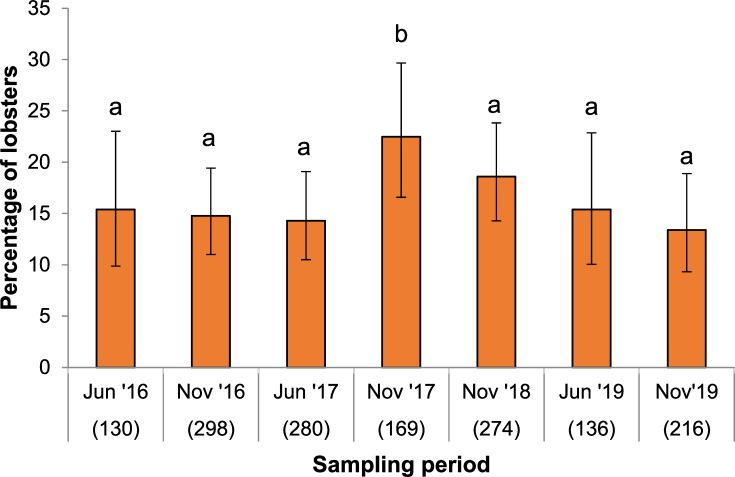
Clinical prevalence of PaV1 over time.Clinical prevalence of PaV1 (percentage of lobsters visibly infected, i.e., diseased) throughout the Puerto Morelos reef lagoon in seven sampling periods: June 2016 (Jun ‘16), November 2016 (Nov ‘16), June 2017 (Jun ‘17), November 2017 (Nov ‘17), November 2018 (Nov ‘18), June 2019 (Jun ‘19), and November 2019 (Nov’19). Numbers in parentheses are sample sizes. Error bars denote 95% confidence intervals. Different letters above bars denote significant differences.